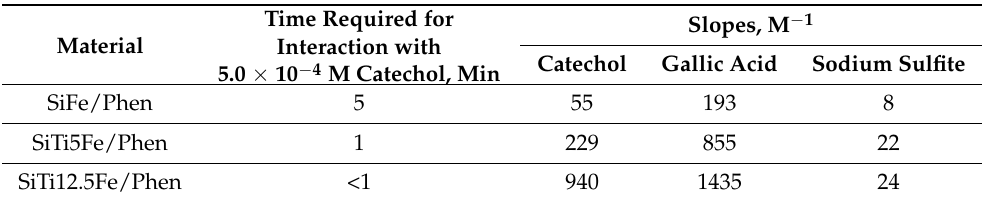
Table 2. The influence of Ti(VI) content in the modified xerogel matrix on the equilibrium time and sensitivity of antioxidant determination.